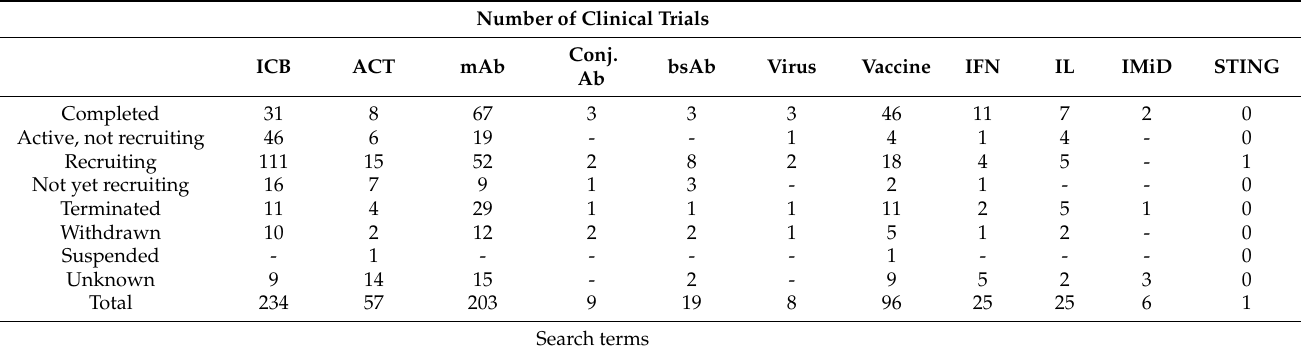
Table 3. The number of clinical trials involving various types of immunotherapy for the treatment of colorectal